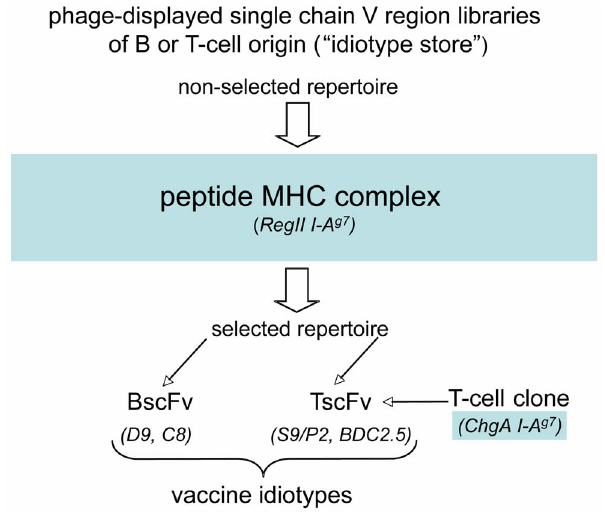
Figure 1. Considerations for the generation of an anti-idiotypic vaccine. a) The peptide MHC (pMHC) complex determines the structure of the idiotype. In this report two pMHC complexes are employed: a) RegII and b) chromogranin A (ChgA)-derived